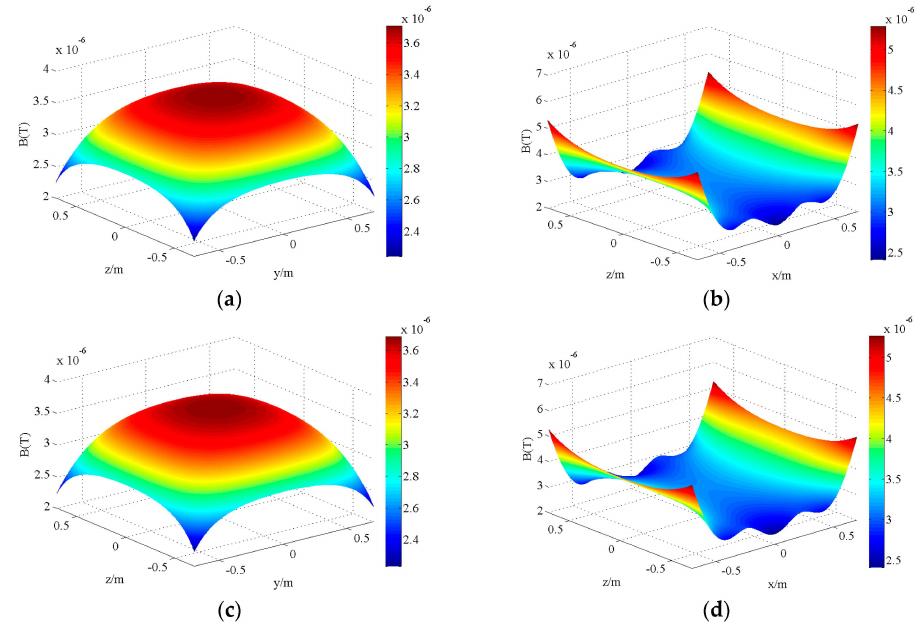
Figure 4. Magnetic flux density resulting from either an analytical calculation or a finite elements calculation: ( a ) in the plane of x = − 0.4 m by analytical calculation; ( b ) in the plane of y ( z ) = − 0.4 m by analytical calculation; ( c ) in the plane of x = − 0.4 m by finite element calculation; and, ( d ) in the plane of y ( z ) = − 0.4 m by finite element calculation.